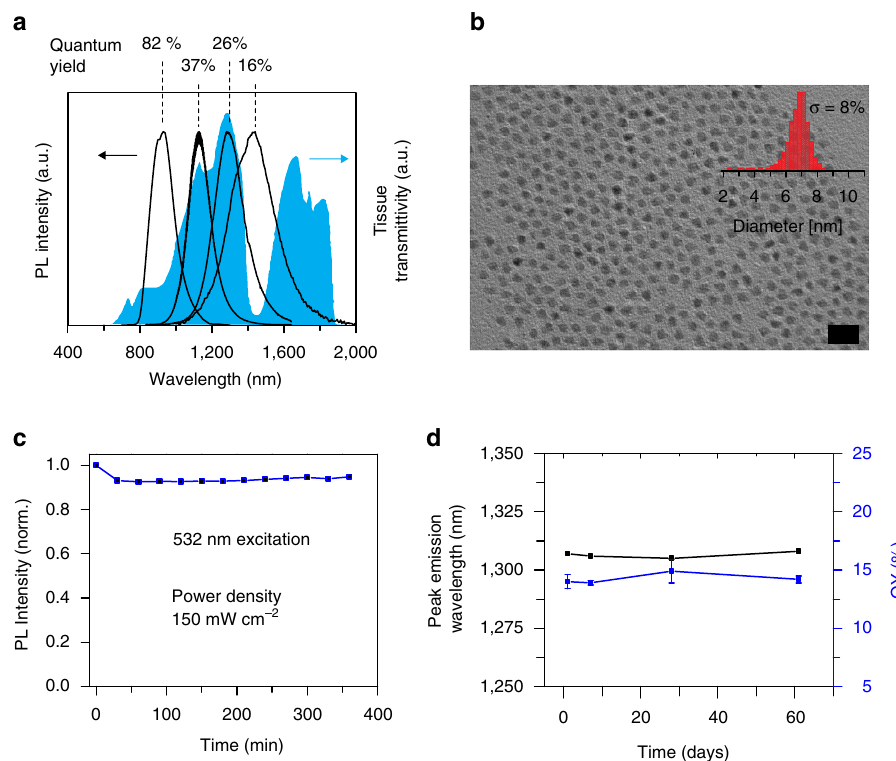
Figure 4 | CSS SWIR QDs for wavelength-selective SWIR imaging. ( a ) CSS QDs spanning the entire sensitivity range of modern InGaAs cameras for wavelength-selective SWIR imaging. Fluorescence spectra are overlaid with a curve for the transmittivity of biological tissue, adapted from ref. 45. ( b ) Representative TEM image of InAsCdSeCdS CSS QDs with a size distribution of 8%. Scale bar, 20nm. ( c ) PL Stability of CSS QD over time during illumination with a 532nm diode laser, with an irradiance of 150mWcm (cid:3) 2 , which is in the range of the flux used in biomedical imaging applications 2 . ( d ) Long-term stability of dispersions of CSS QDs upon storage in open air. QYand position of PL maximum are well maintained for at least two months. Error bars (s.d.) originate from repeating each QY measurement three